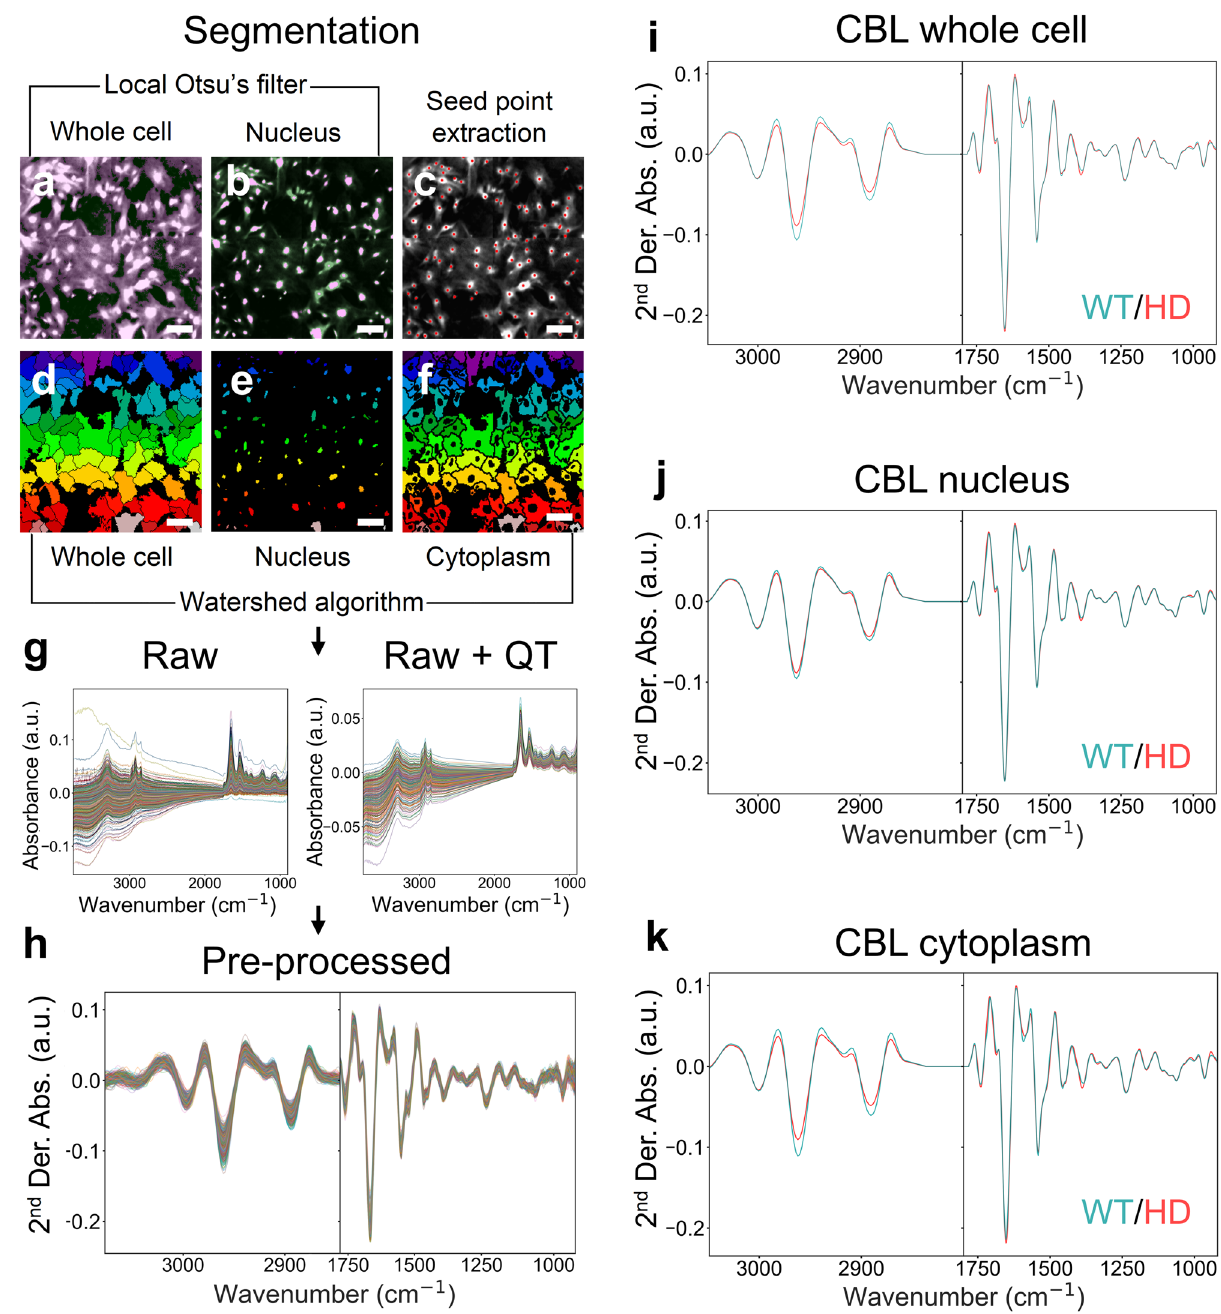
Figure 4. Segmentation reveals differences in the lipid features in the WT and HD astrocytes FTIR signatures. ( a ) Local Ostu’s filter is applied to determine the background from the entire cell or ( b ) nucleus (shown in magenta). ( c ) Seed points are used to localize cells from their estimated center (red dots). ( d ) Seed watershed segmentation applied to whole cells and ( e ) nuclei. ( f ) Watershed segmentation applied to the cytoplasm of the cells (entire cell pixels minus nucleus pixels). Scale bars = 100 µm. ( g ) An example of raw extracted whole astrocyte mean spectra before (left) and after (right) quality testing (QT) and ( h ) pre-processing. ( i ) Whole cell, ( j ) nucleus, and ( k ) cytoplasm average spectra of WT and HD SV40T CBL astrocytes. For visual purpose 2 nd derivative normalized spectra are displayed between 3050 and 2800 cm −1 (lipid-rich region) and 1800–900 cm −1 (“fingerprint”